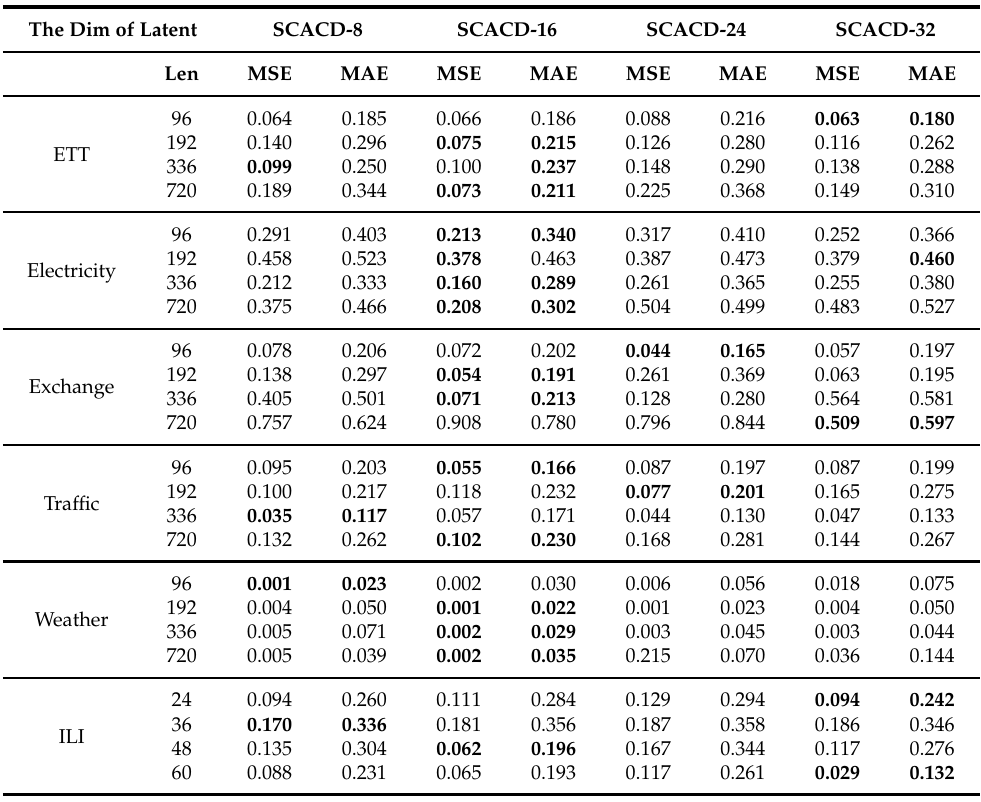
Table 3. The dimensions of the latent variable z in SCACD are taken as 8, 16, 24, and 32. The other hyperparameters are as in Section